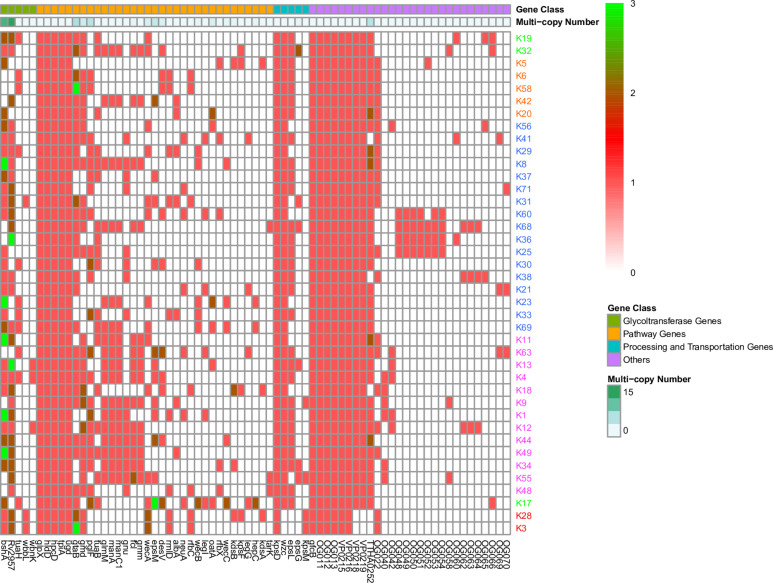
Gene presence or absence in 40 K-serogroup CPSgcs. Columns, corresponding to different genes, were ordered by gene class and occurring frequency in 40 K-serogroup reprehensive strains. In heatmap, each cell indicates the copy numbers of certain gene in corresponding K serogroup, and 1, 2, and 3 copies can be observed in different genes indicated in red, dark red, and green, respectively. Those genes existing in less than 2 K-serogroups were not included; for all gene versions, please refer to Supplementary Figure 4. K-serogroups were classified, ordered, and colored according to Figure 4 (red: group 1, green: group 2, orange: group 3, blue: group 4, purple: group 5).